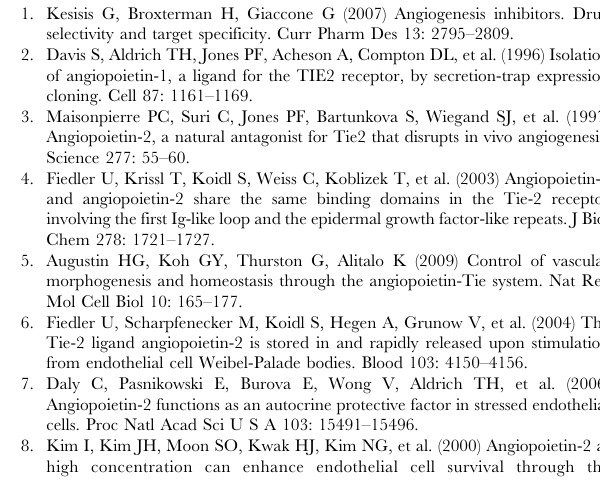
Table S1 Cross-reactivity of LC06 and LC08 to murine, cynomolgus monkey and human Ang-2, and inhibition of Ang-1